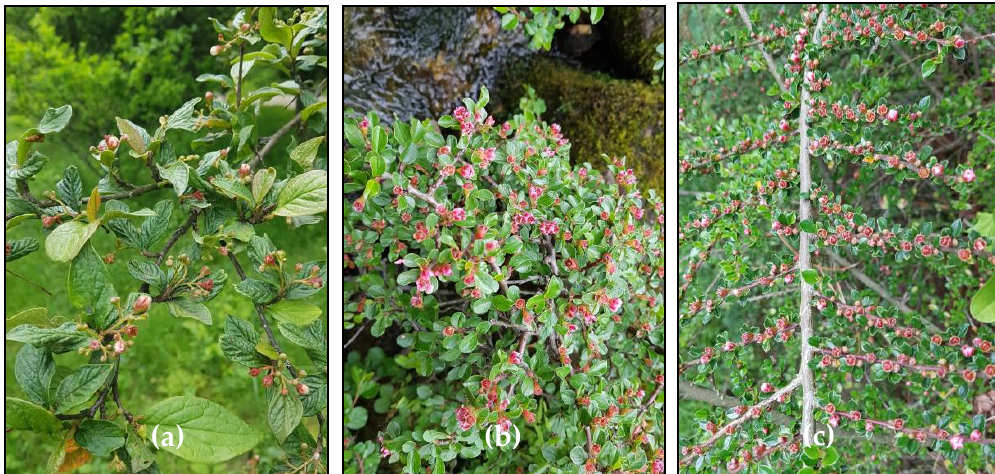
Figure 1. Three representative Cotoneaster species: C. bullatus (a) , C. nanshan (b) and C. horizontalis (c).